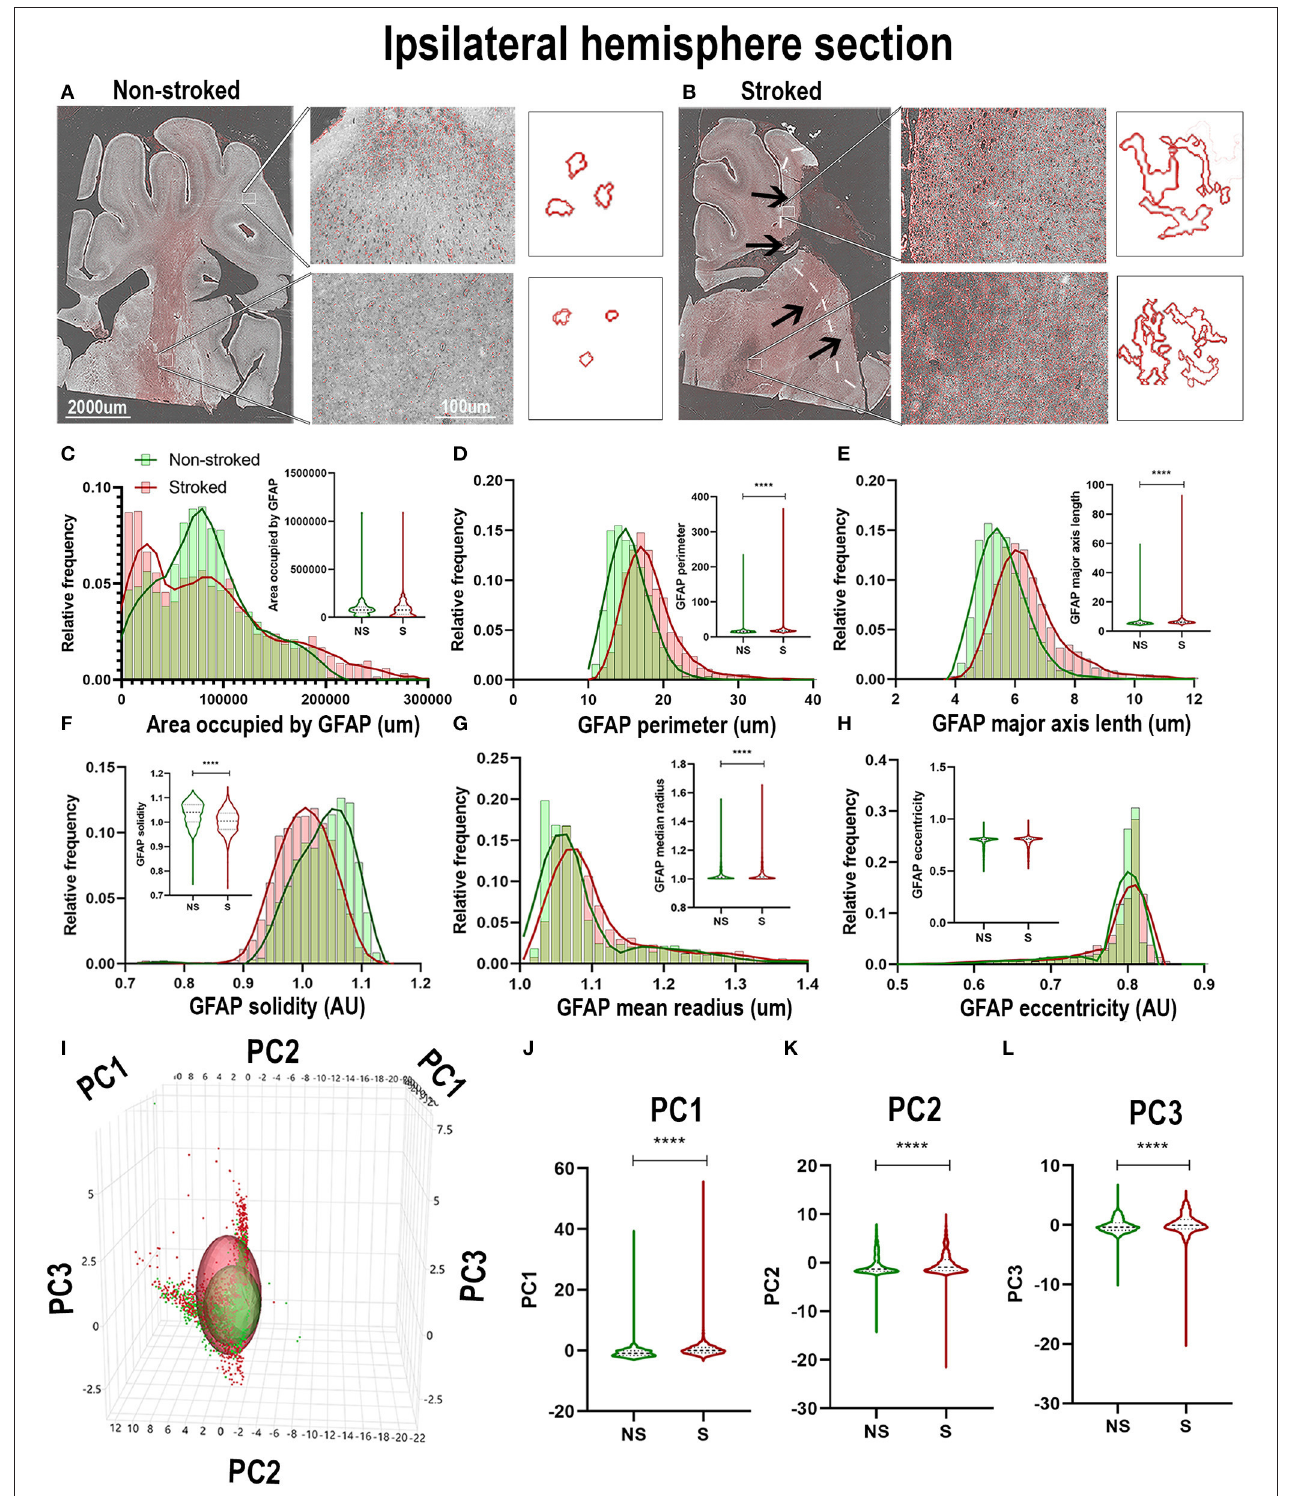
FIGURE 4 | GFAP + areas transitioned to more sprawled and extended morphology after stroke in ipsilateral tissue. Visual differences in density and location of GFAP + areas were observed in ipsilateral sections, between S and NS animals (A,B) . Arrows indicate location of stroke lesion (B) . Significant ( p < 0.0001) increases in perimeter (D) , major axis length (E) , solidity ( F ; p = 0.0003), and mean radius (G) were observed in hemispheric section ROIs of S ( n = 1,848 ROIs) animals relative to NS ( n = 1,668 ROIs) animals. There was a significant ( p < 0.0001) decrease observed in GFAP + area occupied (C) and solidity (F) of IBA1 + ROIs of in S animals compared to NS animals. No significant difference was seen in eccentricity (H) . PCA (I) analysis revealed a significant ( p < 0.0001) difference in PC1-3 (J–L) in S animals compared to NS animals. **** p < 0.0001.